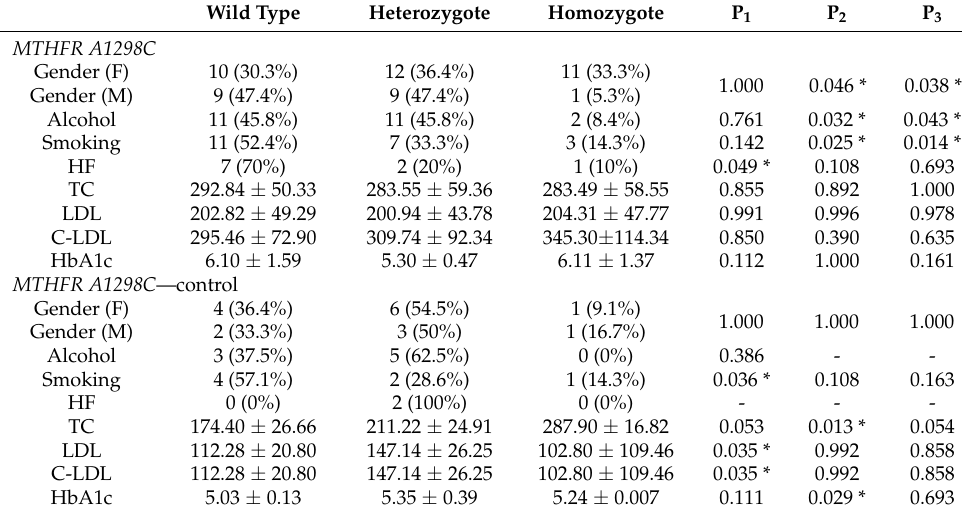
Table 6. MTHFR A1298C and cardiovascular risk factors.